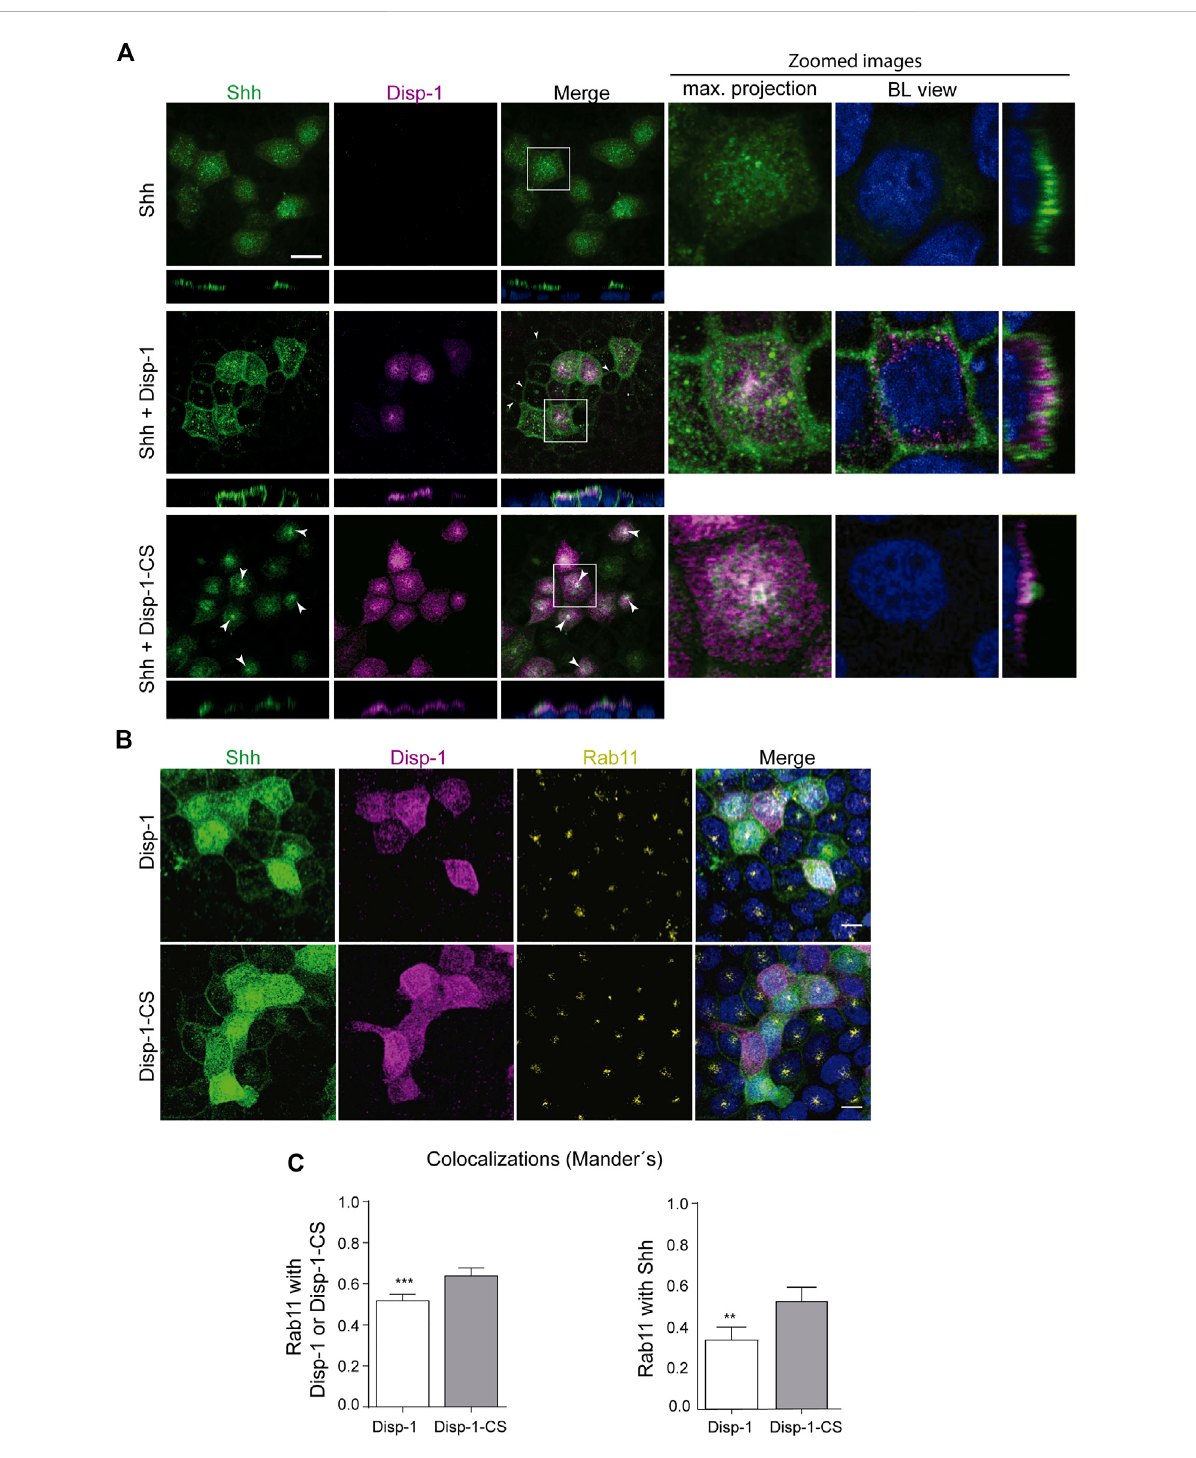
FIGURE 6 Distribution of newly synthesized Shh when co-expressed with Disp-1 or Disp-1-CS. (A) Polarized MDCK cells in glass coverslips were microinjected to express Shh alone (upper panels), together with Disp-1 (middle panels), or Disp-1-CS (lower panels). Images of indirect immuno fl uorescence for Shh (green) and Disp-1 proteins (HA, magenta) are shown in maximal projections with zoomed images including basolateral(BL)viewsattheright.WhencoexpressedwithDisp-1,Shhisnotonlydistributedattheapicaldomainbutalsoappearsatbasolateral bordersofnon-microinjectedneighboringcells(arrowheads),re fl ectingitsincreasedsecretion.Meanwhile,whencoexpressedwithDisp-1-CS,Shh became enriched in a punctate subapical compartment (arrow heads) reminiscent of Rab11-ARE. (B) Colocalization of Rab11 with Shh and Disp-1.